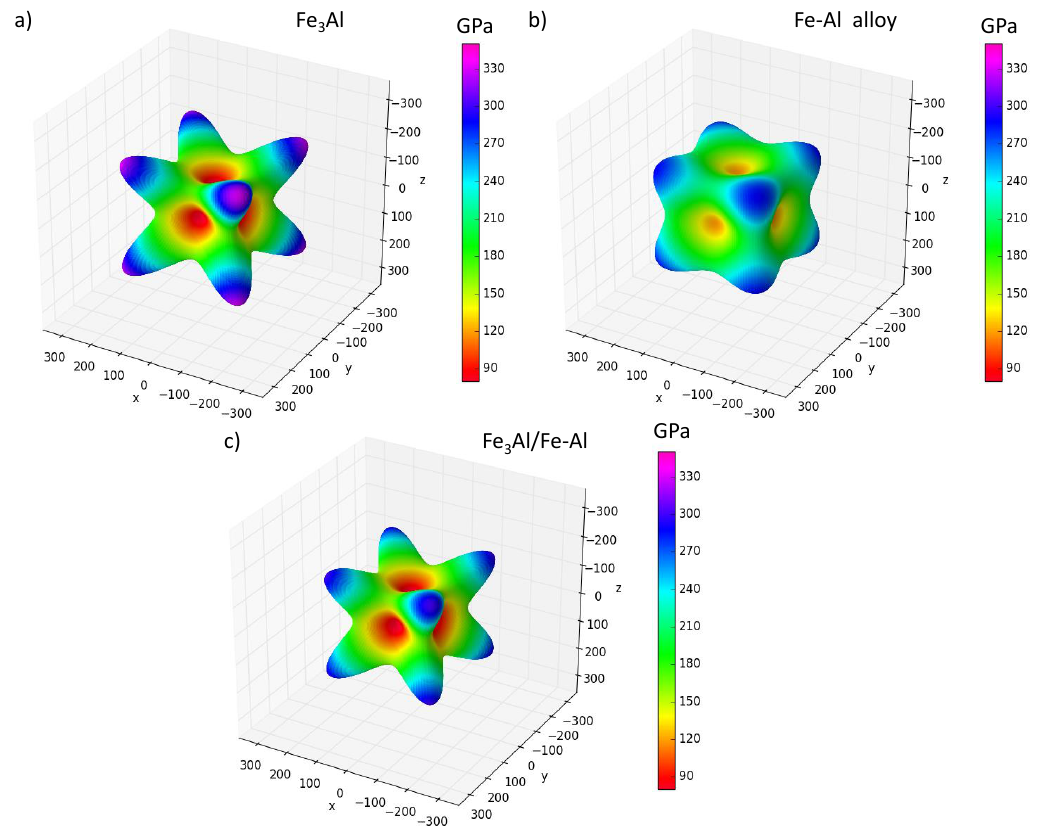
Figure 5. Directional dependencies of Young’s modulus of the ground-state configuration of Fe 3 Al compound ( a ); disordered Fe-Al ( b ) and the nanocomposite consisting of these two phases ( c ). All three dependencies were visualized using the SC-EMA software package (see it freely available at the web page scema.mpie.de)